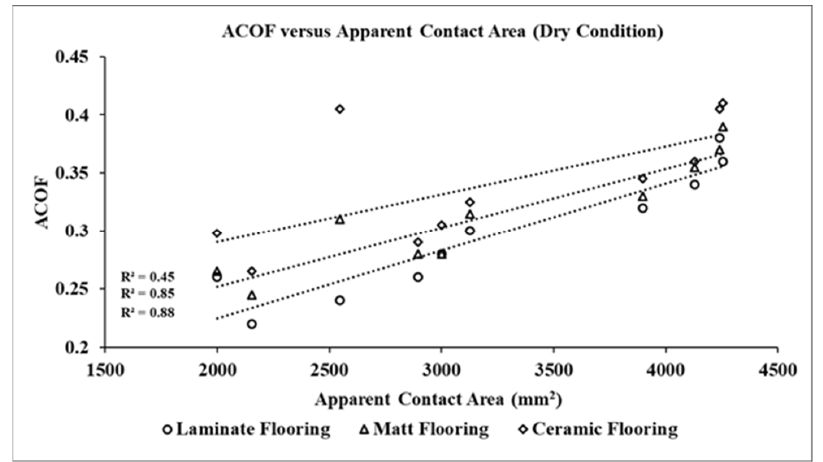
Figure 7. Correlation between apparent contact area and ACOF across the shoes in dry condition.